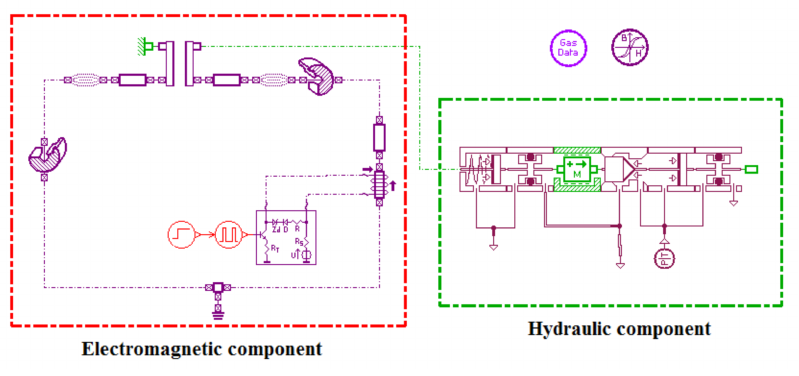
Figure 5. AMESim model of VCM-DHPV. Table 1. Design parameters of VCM-DHPV.